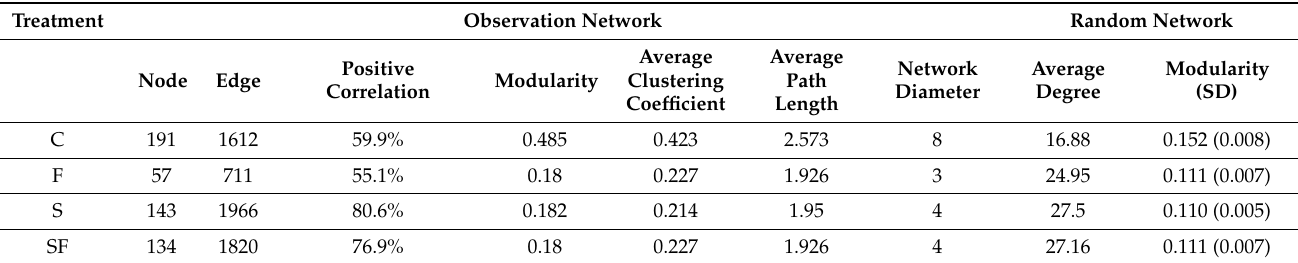
Figure 4. Difference in the network interactions of phytoplankton assemblages in the C ( a ), F ( b ), S ( c ), and FS ( d ) treatments. Nodes are colored according to phytoplankton phylum, while node size represents the degree of the node. Table 3. Topological parameters of the phytoplankton observation network and its associated stochastic network in different treatments.